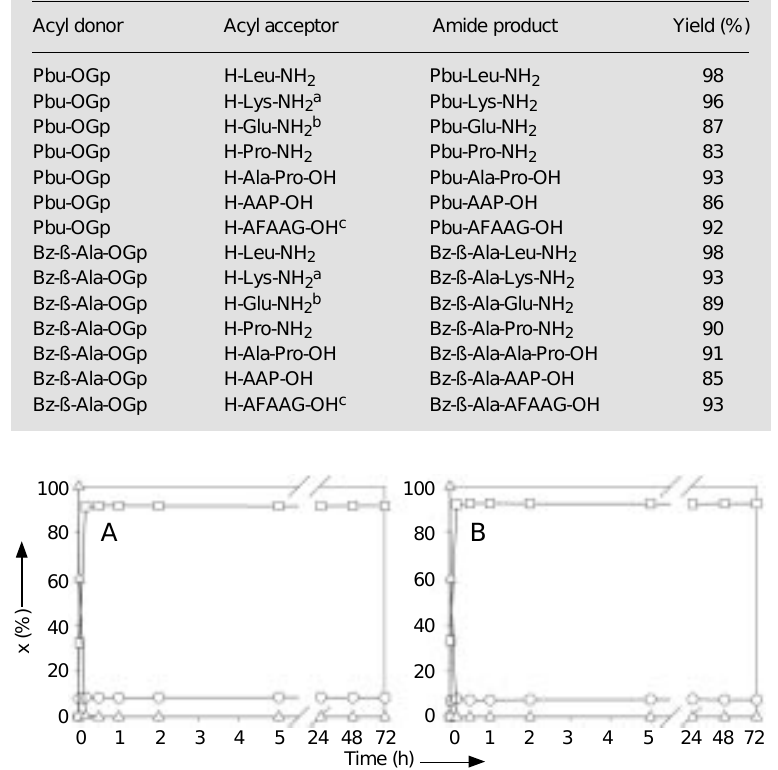
Figure 12 - Course of the clostripain-catalyzed coupling of Bz-ß-Ala-OGp and Pbu-OGp with H-Ala-Phe-Ala-Ala-Gly-OH (44). A , Bz-ß-Ala-OGp; B , Pbu-OGp. Triangles, Bz-ß-Ala-OGp/Pbu- OGp; squares, Bz-ß-Ala-Ala-Phe-Ala-Ala-Gly-OH/Pbu-Ala-Phe-Ala-Ala-Gly-OH; circles, Bz-ß- Ala-OH/ Pbu-OH. Conditions: 0.2 M HEPES-buffer, pH 8.0, 0.1 M NaCl, 0.01 M CaCl 2 , 5% DMF, 25 o C; [acyl donor]: 2 mM, [acyl acceptor]: 4 mM; x = product yield.